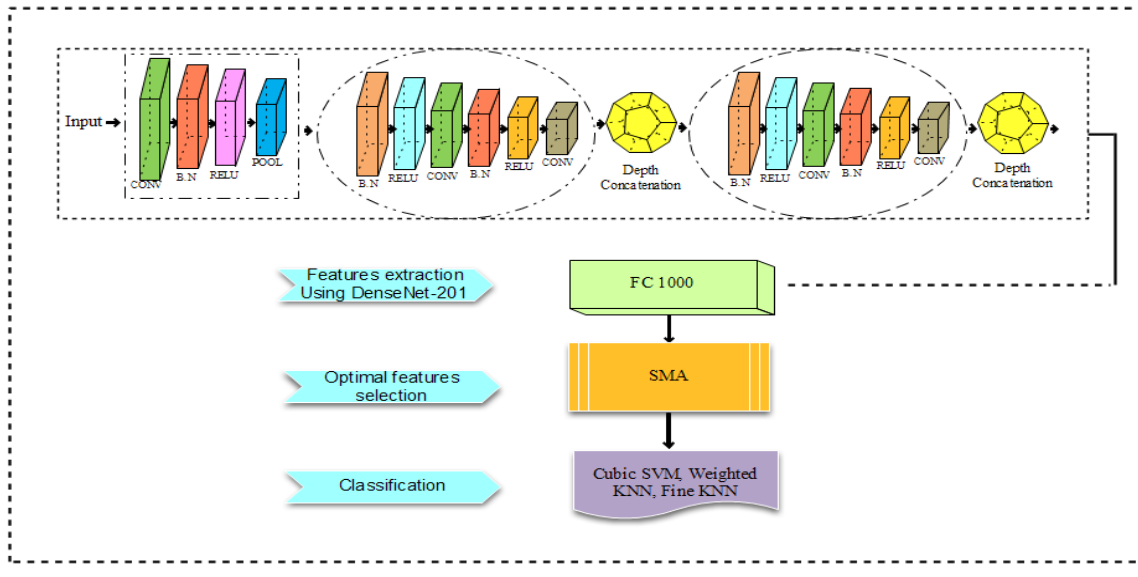
Figure 3. Steps of the proposed classification model.